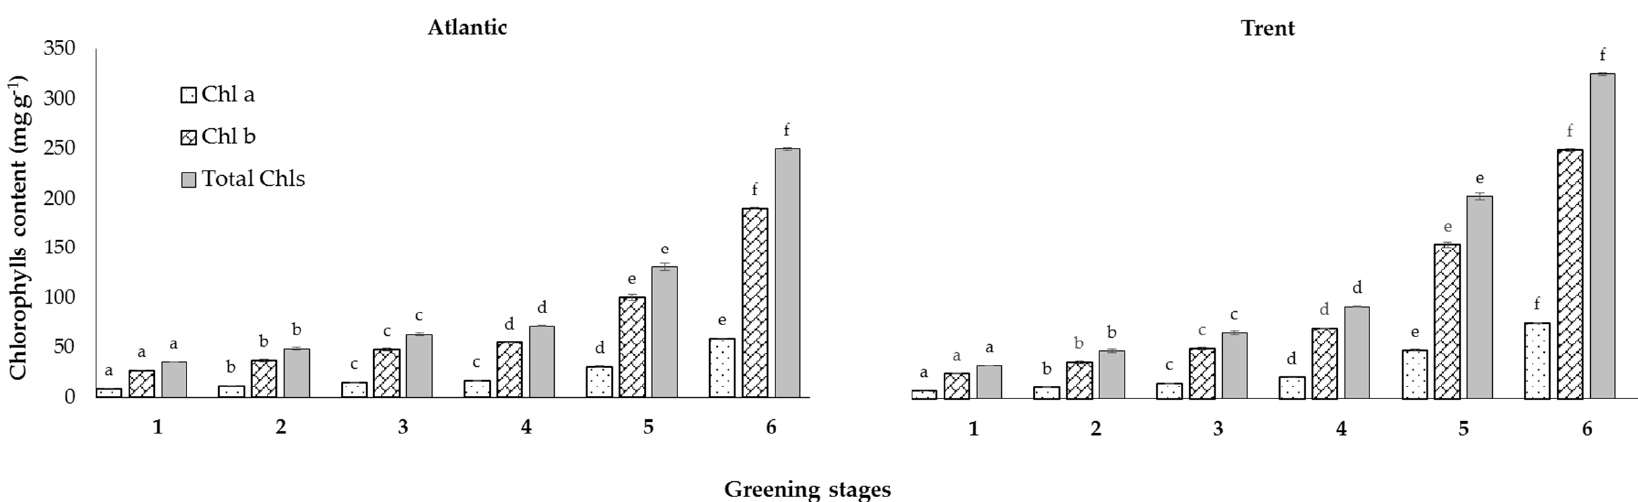
Figure 2. Chlorophyll content of ‘Atlantic’ and ‘Trent’ potato cultivars under six greening stages during storage at room conditions (22 °C) with a 12 ‐ h shift of light ‐ dark cycles. The bars with different letters indicate a significant difference ( p < 0.05) between the greening stages. The vertical bars represent the standard error of the mean (n = 10).